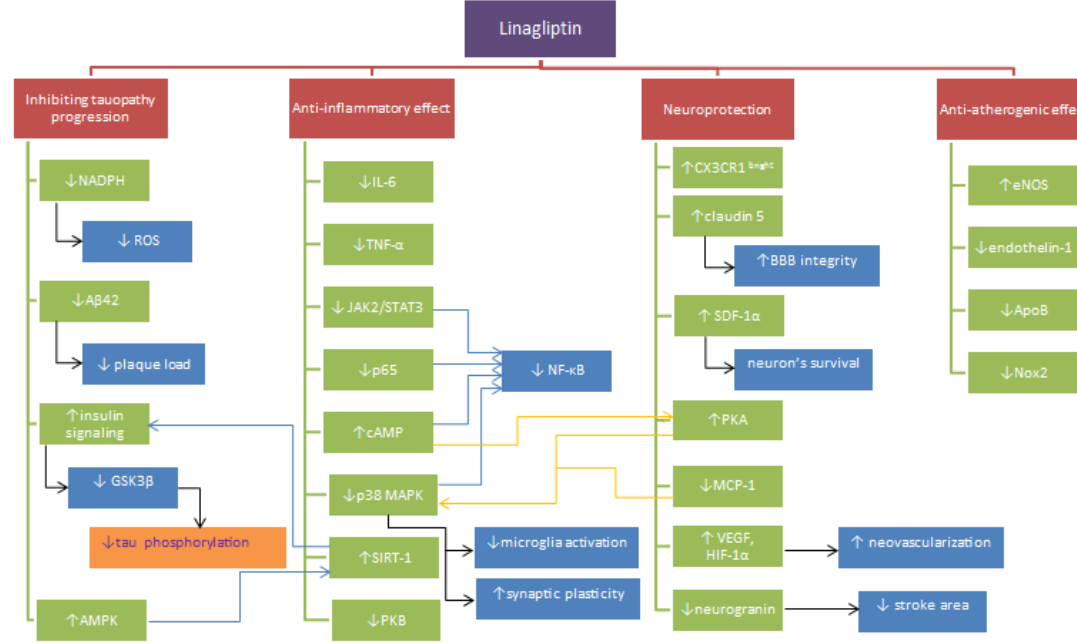
Figure 1. Proposed mechanisms of linagliptin activity. Note: ↓ = reduction, ↑ = increase, SDF1 = stromal cell-derived factor 1, CX3CR1 brigh - monocytes type, MCP-1 = Monocyte chemoattractant protein-1, JAK2 = Janus kinase 2, AMPK = 5′AMP-activated protein kinase , STAT3 = Signal transducer and activator of transcription, NF-κB p65 = nuclear factor kappa-light-chain-enhancer of activated B cells, SIRT1 = NAD-dependent deacetylase sirtuin-1, Aβ = amyloid beta, GSK3β = Glycogen synthase kinase 3 beta, ROS = reactive oxygen species, tau = tau protein, NO = nitric oxide, NADPH = Nicotinamide adenine dinucleotide phosphate, Nox2 = NADPH oxidase 2, IL-6 = Interleukin 6, TNF-α = tumor necrosis factor α, p38 MAPK = P38 mitogen-activated protein kinases, PKA = protein kinase A, PKB = protein kinase B, cAMP = 3′,5′-cyclic adenosine monophosphate, Apo B = Apolipoprotein B, VEGF = vascular endothelial growth factor, eNOS = endothelial nitric oxide synthase, HIF-1α = hypoxia-inducible factor 1, p65 = subunit of NF-κB.